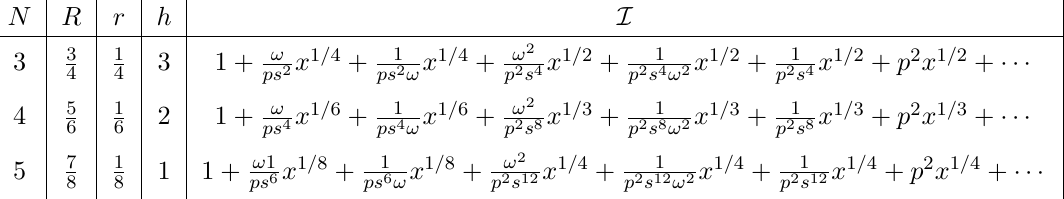
Table 7 . Computation of the superconformal index for di(cid:11)erent values of N up to order O In the last column we report the (cid:12)rst terms of the